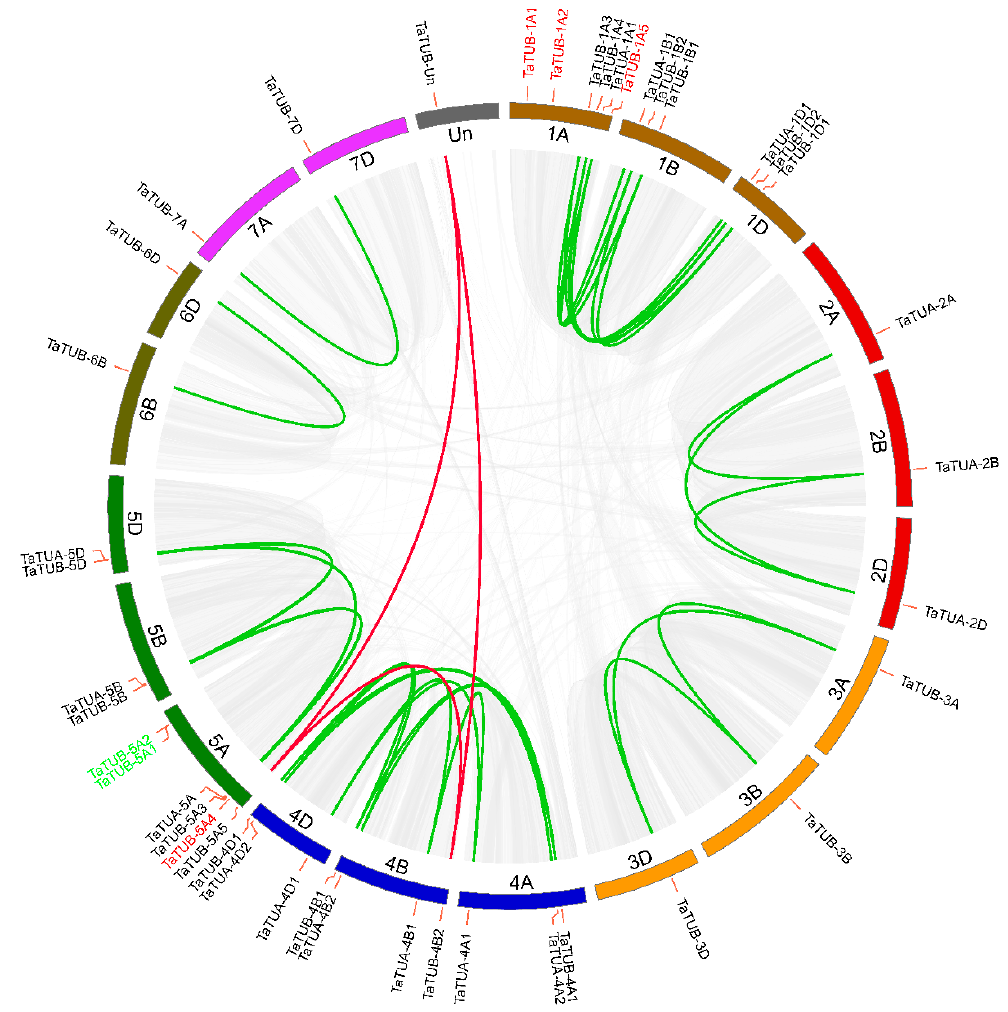
Figure 1. Synteny of the TaTUA and TaTUB genes in wheat. All syntenic blocks of the wheat genome are linked by grey lines, while colored lines link syntenic relationships of the TaTUA and TaTUB genes.